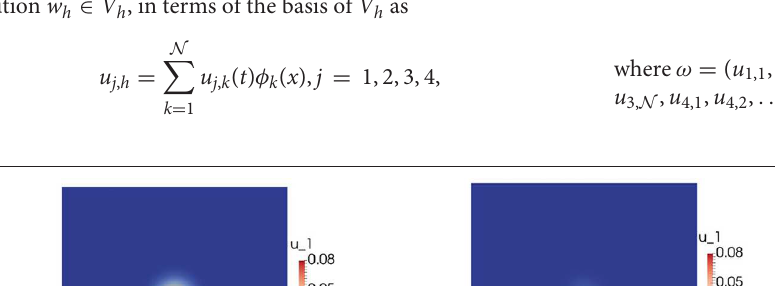
Frontiers in Physics |